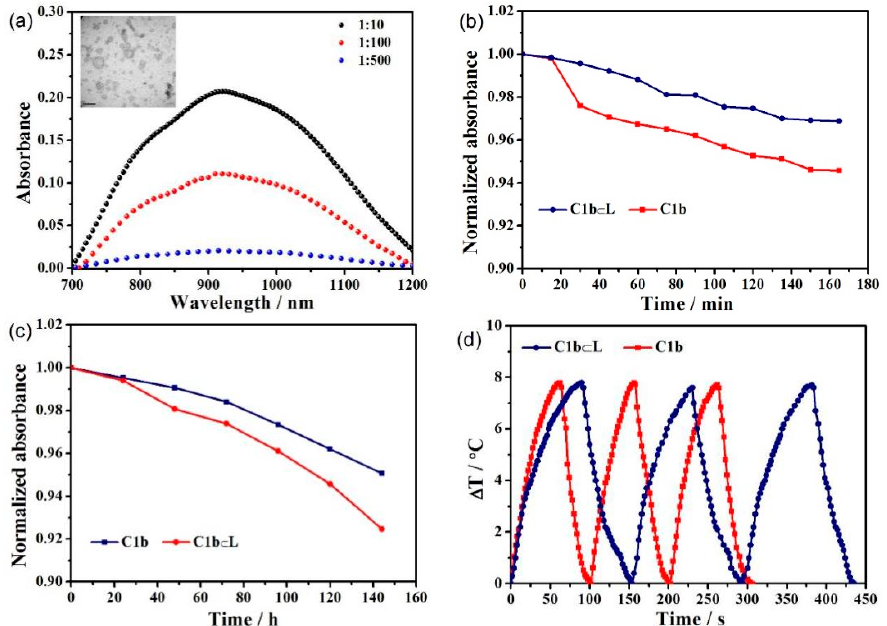
Figure 4. ( a ) UV/Vis/NIR absorption spectra of C1b ⊂ L with different ratios of C1b to liposomes in PBS and TEM images of C1b ⊂ L. ( b ) The UV/Vis/NIR absorption spectra were estimated after the solution of C1b and C1b ⊂ L illuminating in every 15 min at 860 nm. ( c ) The UV/Vis/NIR absorption spectra were estimated after the solution of C1b and C1b ⊂ L placing 24 h at 860 nm. ( d ) Thermal conversion efficiency of the solution of C1b and C1b ⊂ L was measured for continuous 3 times.